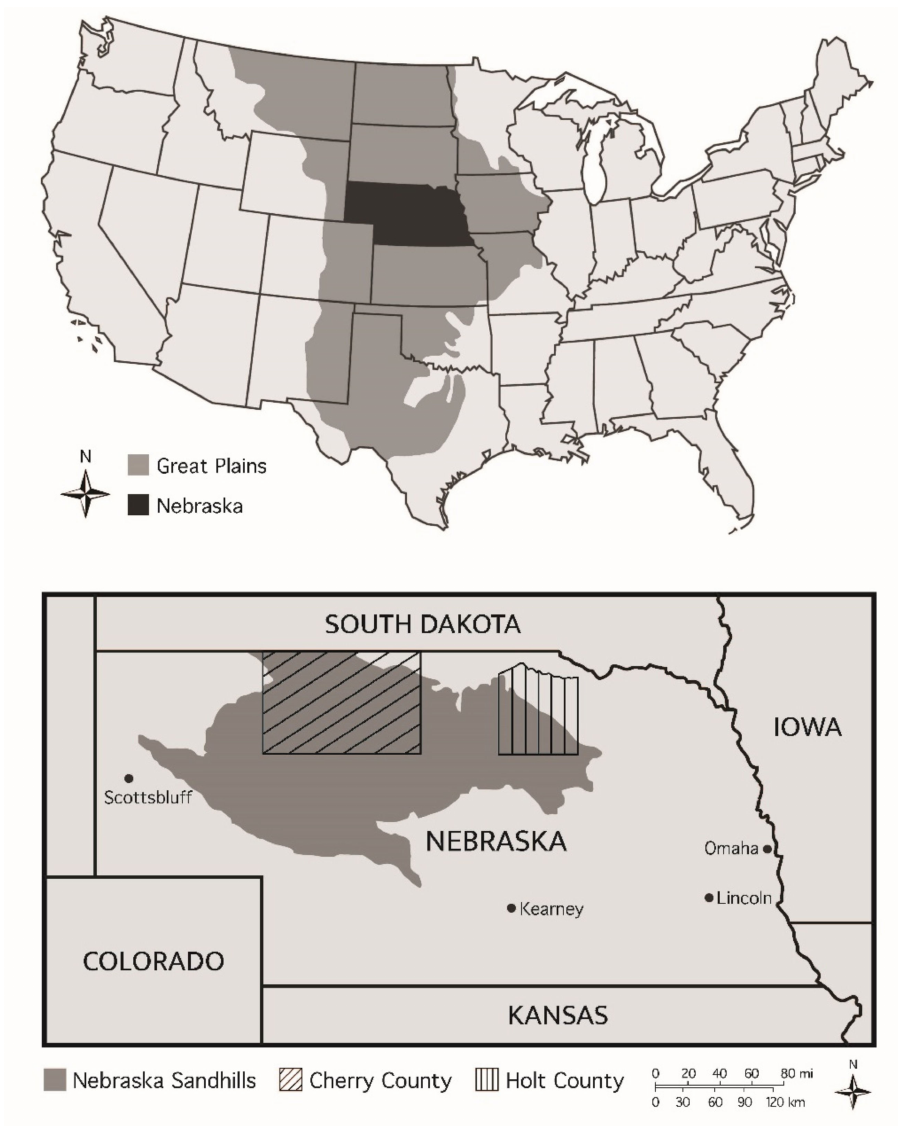
Figure 1. Map of the study area in the North American Great